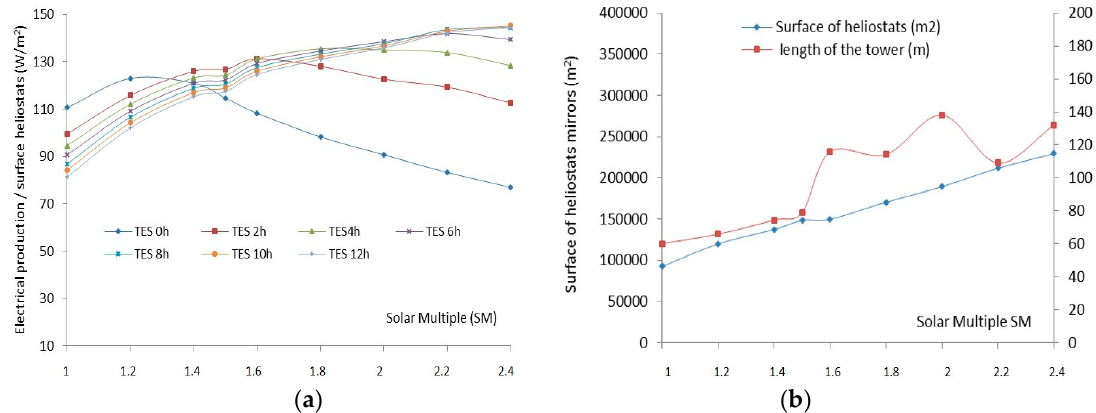
Figure 7. ( a ) Solar multiple effect ( SM ) on electrical production by surface heliostats under different values of TES . ( b ) Solar multiple effect on the surface of the heliostats mirrors (m 2 ) and the length of the tower (m).